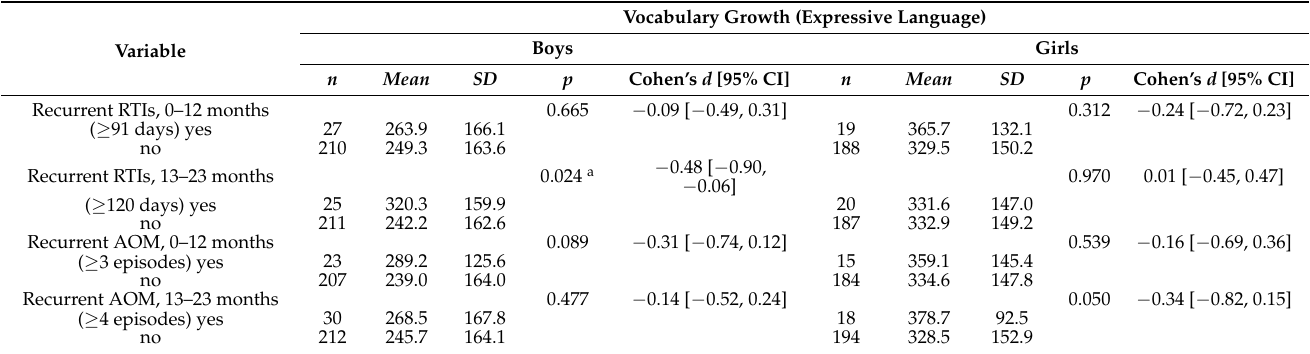
Table 2. Comparison of vocabulary growth between 13 and 24 months of age in children with and without recurrent RTIs and AOM. t -test for independent